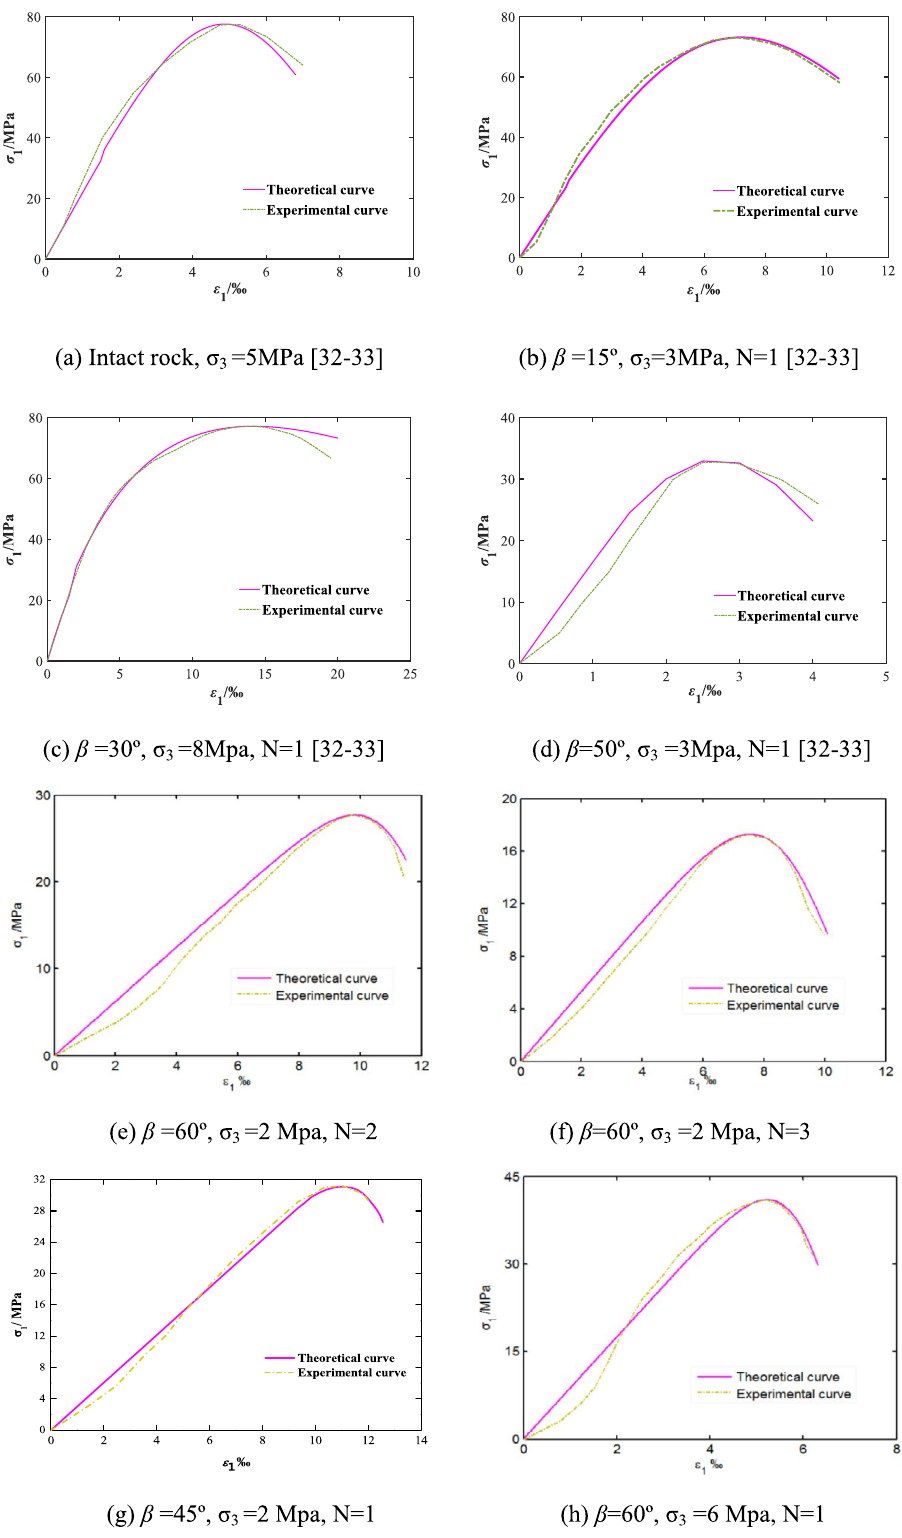
Figure 8. Comparison of test and theoretical constitutive curves of rock